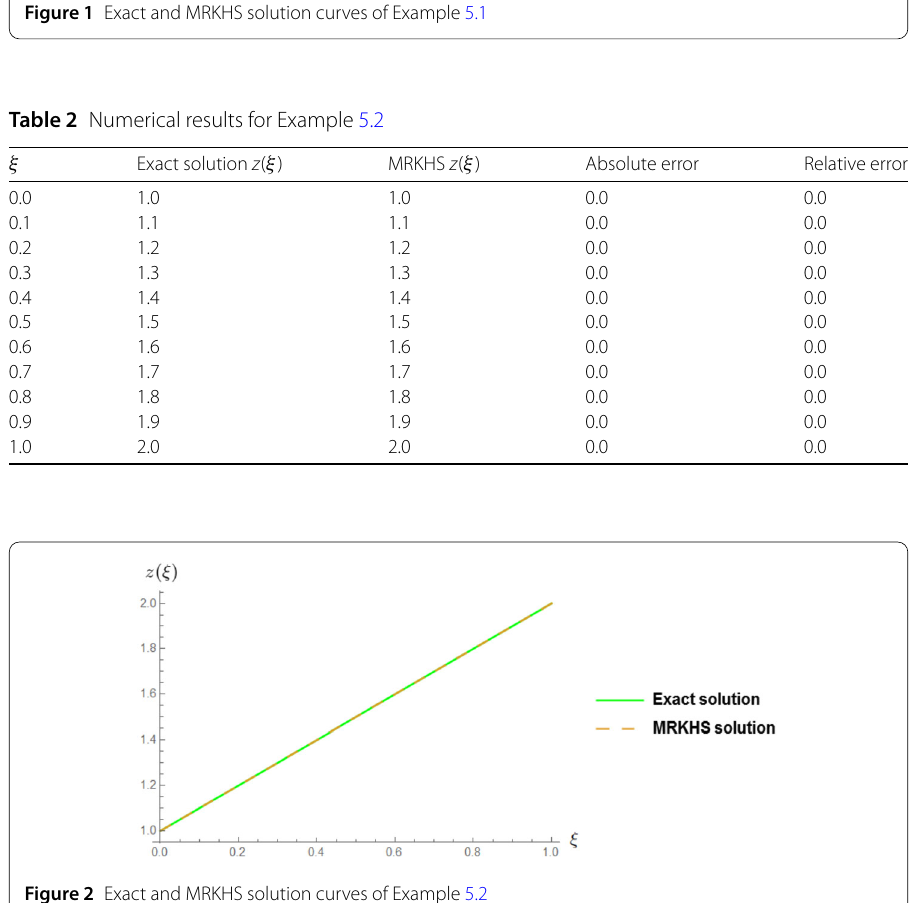
Figure 2 Exact and MRKHS solution curves of Example